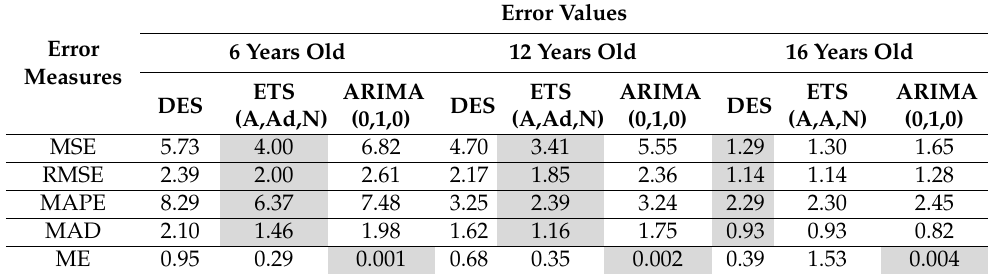
Table 1. Models comparison of fitted accuracy.